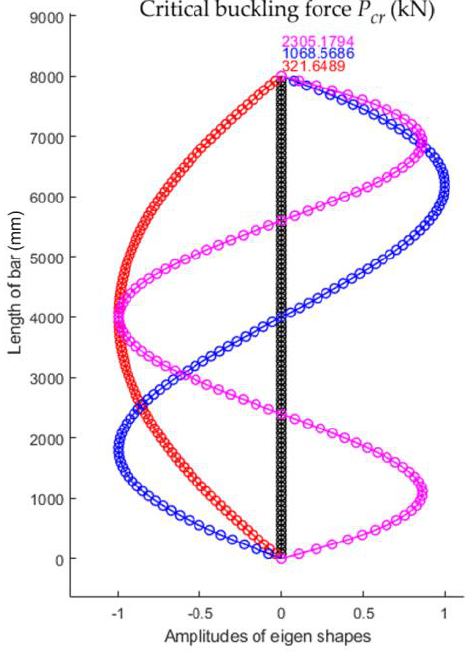
24 of 28 Figure 18. The first three shapes of stability loss and corresponding critical buckling forces for the bar with parabolic variation in the second moment of inertia along the bar axis. 3.4.2. Critical Buckling Forces for the Sinusoidal Variation in the Second Moment of In- ertia of the Cross-Section along the Bar Using the numerical model with 100 finite elements, for the bar with sinusoidal